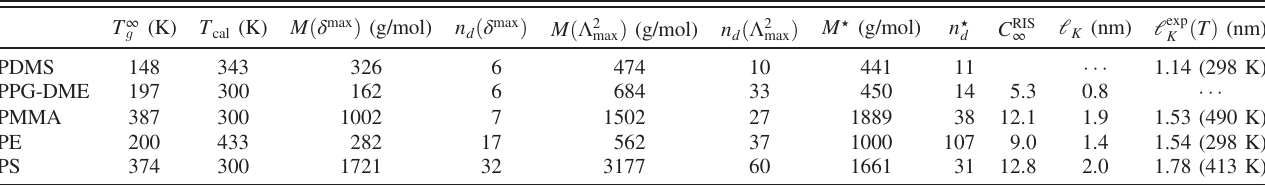
TABLE III. T ∞ and calibration temperature T g corresponding to the maxima of δ and Λ 2 at M ⋆ , from RIS calculations. We use M ⋆ as determined in Fig. 2(e). Also shown are C RIS ∞ , the ≡ C RIS Kuhn length l ∞ b eff calculated from the simulations at T K (typically for T ≫ T ). We have not found a reliable estimate for l g C RIS ∞ for PDMS at T , as discussed in the text. g